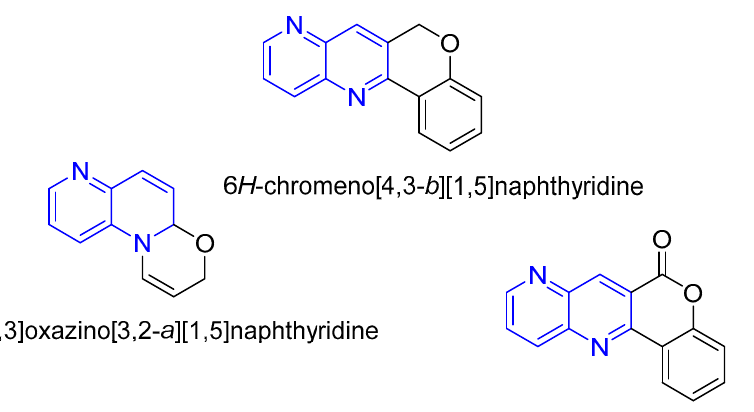
Figure 6. Examples of fused 1,5-naphthyridines with oxygen-containing heterocycles.